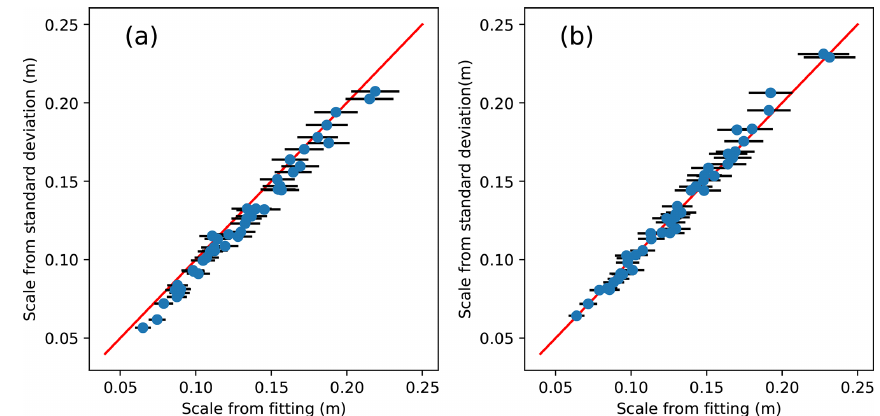
Figure 2. (a) Following Woodworth et al. (2021), we compare λ diagnosed from a Gumbel fit to 484 years of simulated annual maxima √ ( x axis) with σ 6 /π , where σ is the standard deviation of the 484 annual maxima, for UK coastal sites. The two should be the same in the case of the annual maxima conforming to a Gumbel distribution. The horizontal error bars represent 95% uncertainty in the fitted λ . The red line represents a ratio of 1. Each point represents the site of a tide gauge on the coast of the UK. (b) As (a) , but instead of simulated annual maxima, at each site we use 484 random variates drawn from the Gumbel distribution, using the λ for that site determined by the fit in (a)